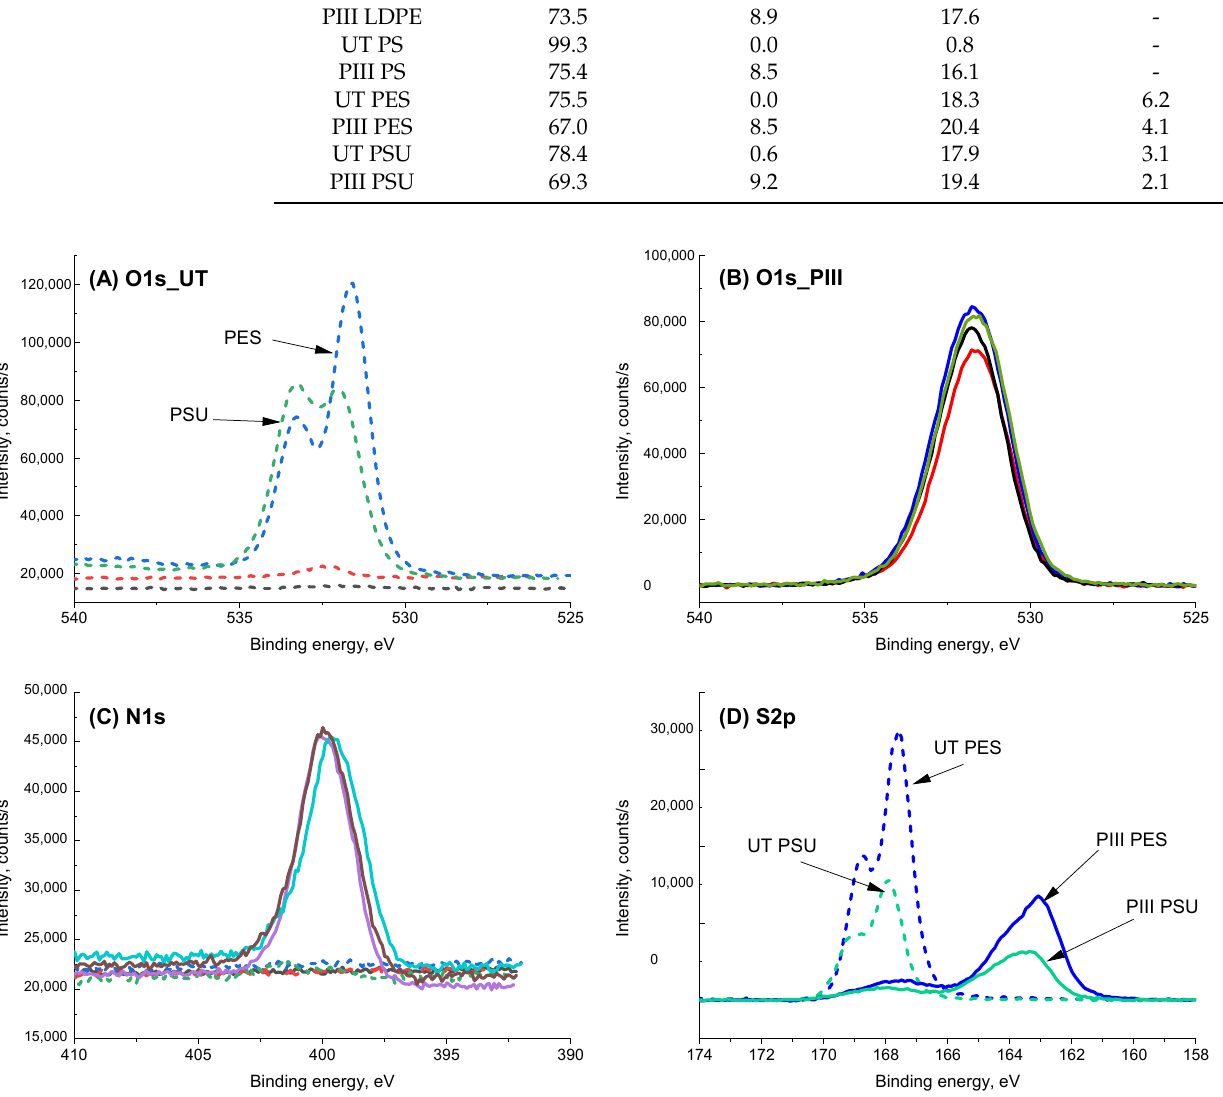
Figure 5. Comparison of XPS high-resolution scans. O1s peak of the 4 polymers before ( A ) and after ( B ) the PIII treatment. N1s peaks of the 4 polymers before and after the PIII treatment ( C ). S2p peaks of PES and PSU before and after the PIII treatment ( D ). Dashed lines and solid lines represent untreated and PIII-treated polymers, respectively.